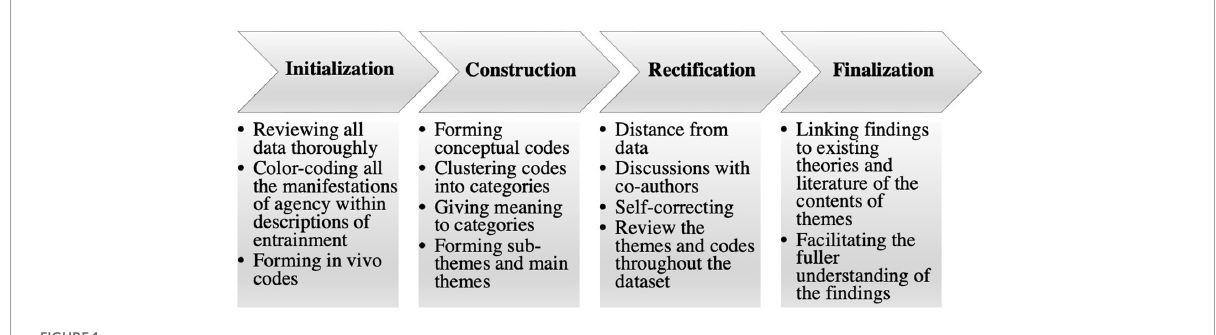
FIGURE1 The process of theme development after Vaismoradi et al.